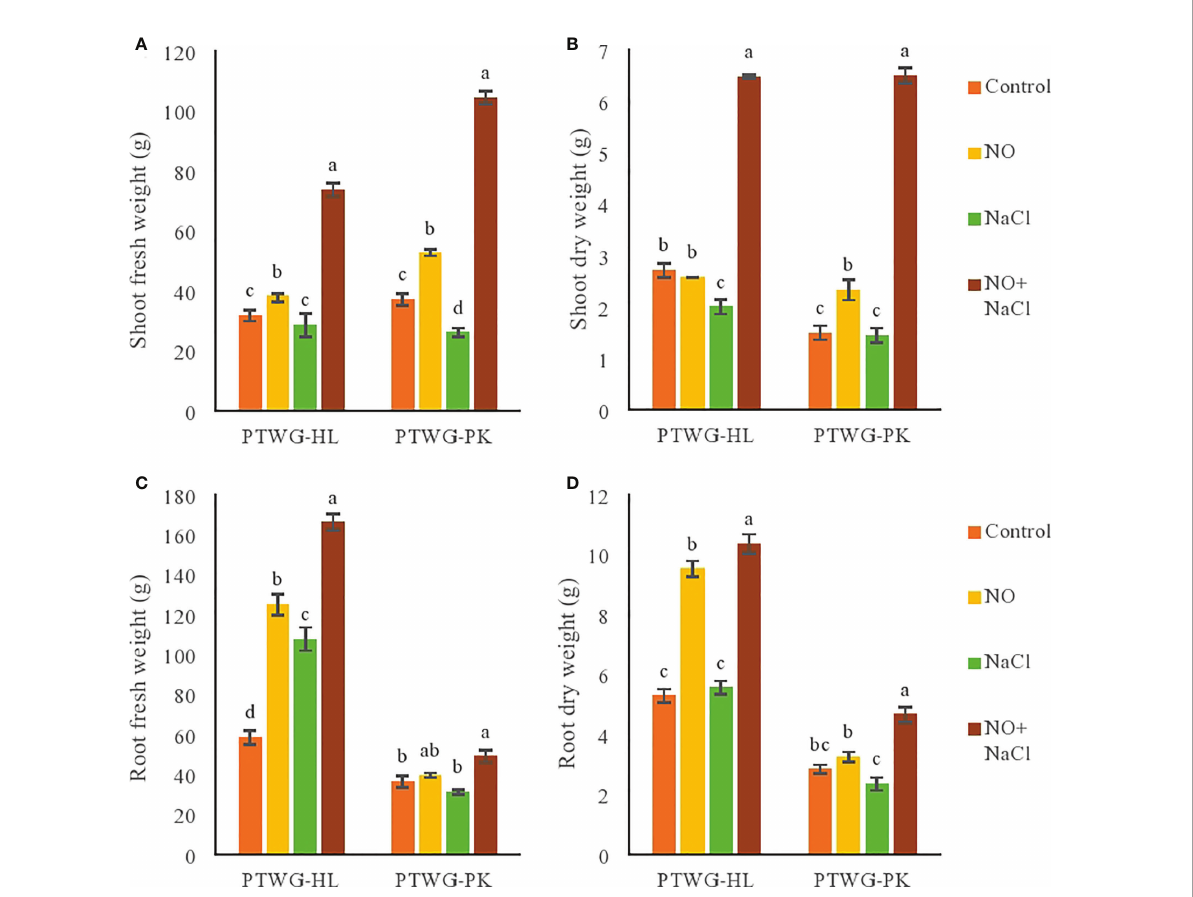
FIGURE 1 Shows fresh and dry weight of root as well as shoot of forty-two days old ecotypes of turnip ( Brassica rapa L.) under sodium chloride and nitric oxide stress. (A) Shoot fresh weight, (B) Shoot dry weight, (C) Root fresh weight, (D) Root dry weight. Means with the same letters on each bar do not differ signi fi cantly at the 5%